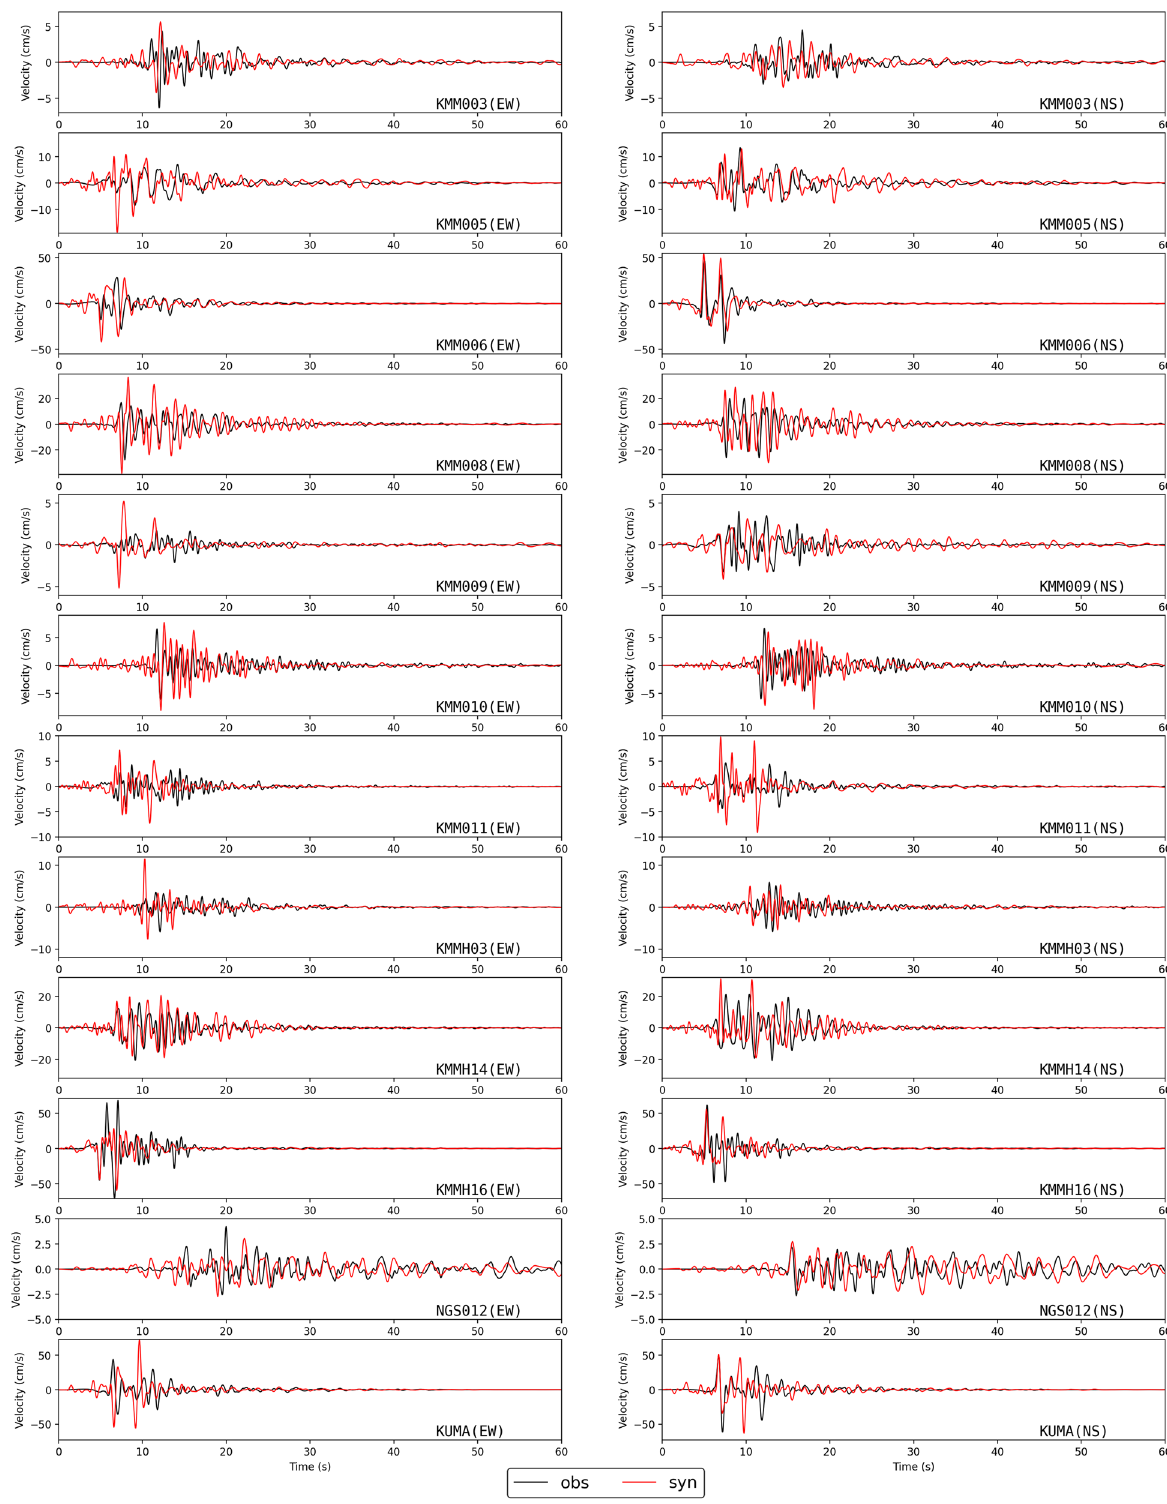
Fig. 9 Synthetic and observed velocity time histories (0.2–2 Hz) of the reference case for the earthquake of 2016/04/14 21:26 ( M w 6.1). Black lines indicate the observed velocities. Red lines indicate the synthetic